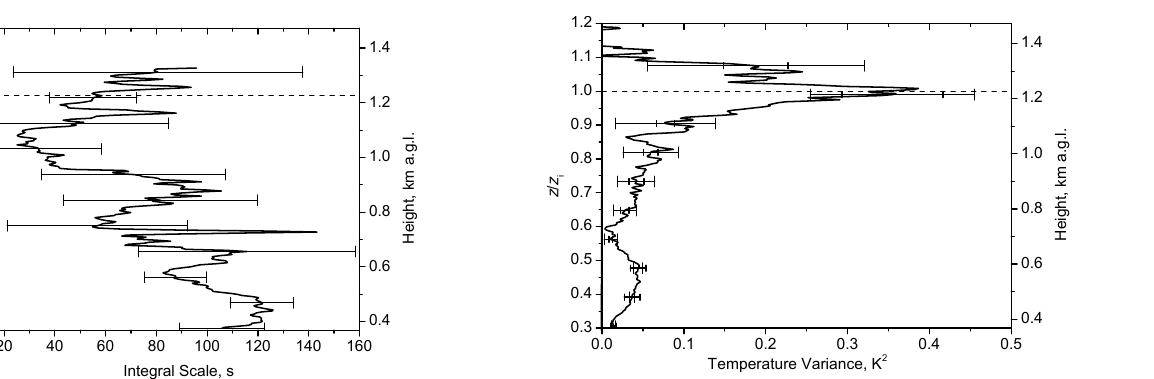
Figure 8. Integral scale of the temperature fluctuations shown in Fig. 5 (1h period between 11:00 and 12:00UTC, 24 April 2013). Error bars show the noise errors. The mean CBL height z i of 1230m (dashed line) was determined with the Haar-wavelet analysis of β par and was used for the relative height scale z/z i .